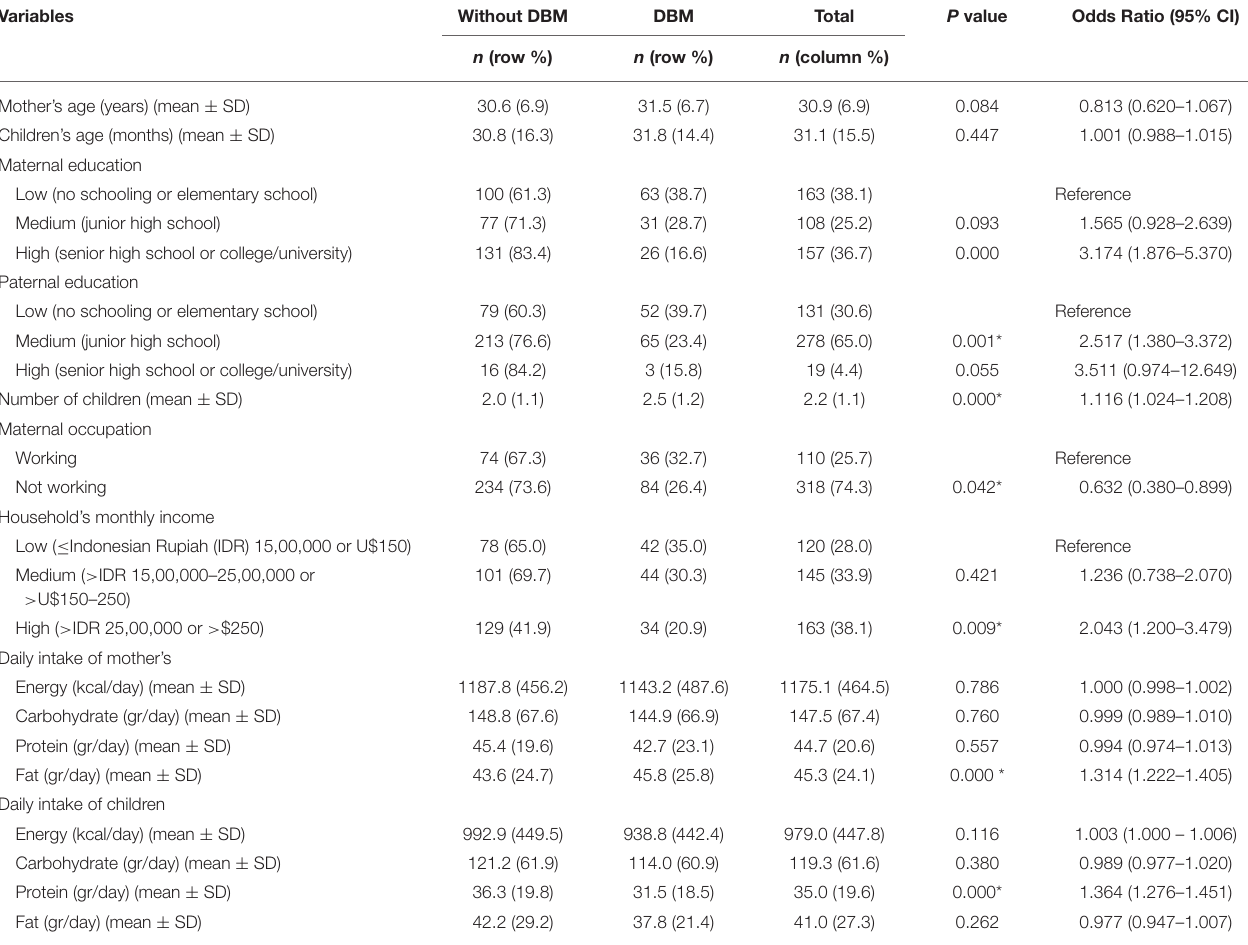
TABLE 4 | Comparison of socio-economic and macronutrient intake between household with and without the double burden of malnutrition (DBM).